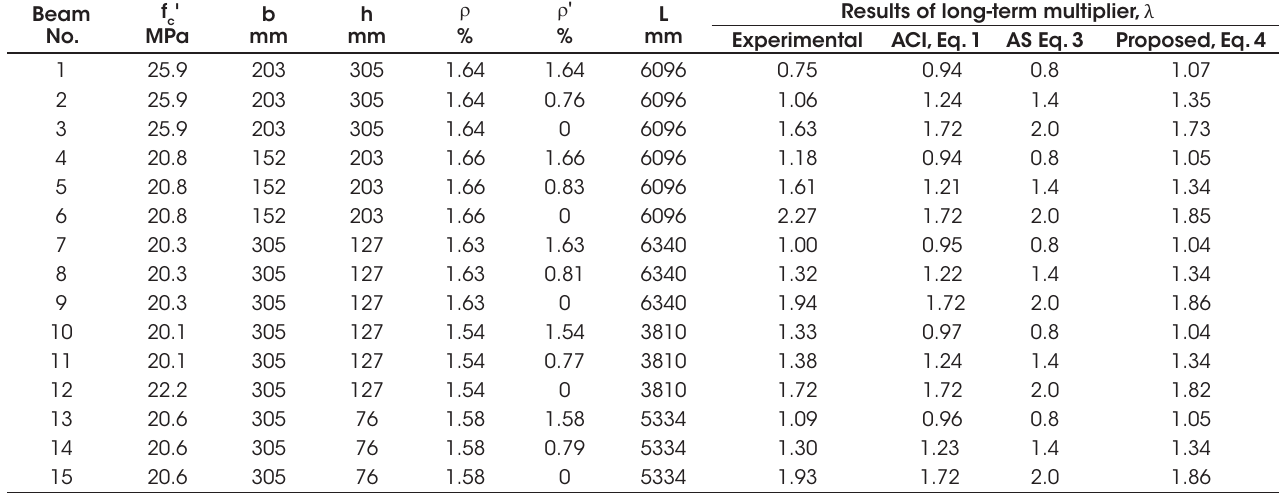
) with experimental results by [27], λ